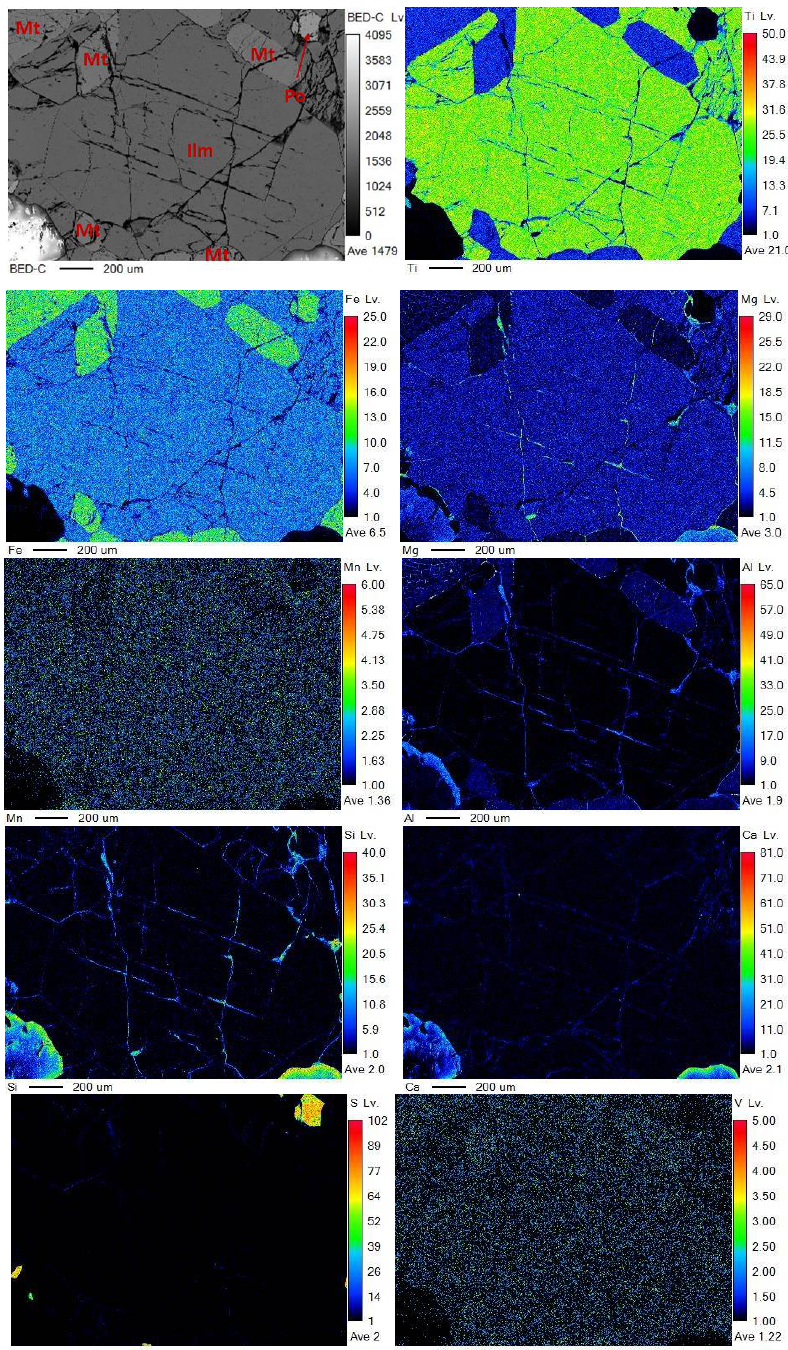
Figure 6. Distribution of the main elements in ilmenite. Theoretically, the contents of TiO 2 and FeO in ilmenite (FeTiO 3 ) are 52.65% and 47.35%, respectively. However, it can be seen from Table 5 that while the TiO 2 content in ilmenite was significantly higher than the theoretical value, the FeO content was lower. In addition, ~5% MgO was present, which indicates that the ilmenite contained a large amount of MgTiO 3 because its theoretical TiO 2 content is as high as 63.77%. In addition, the TiO 2 and MgO contents of sample Nos. 12–14 were lower than those of other samples, while their FeO and MnO contents were higher, indicating that the TiO 2 content in ilmen- ite was negatively correlated with that of FeO and that the similarity between Mg 2+ and Fe 2+ is stronger than that between Mn 2+ and Fe 2+ [46]. Finally, Table 5 shows that ilmenite also contained V, Mn, Al, Si, Na, K, Cr, Co, Ni, S, and P, of which only V, Mn, Al, and Co